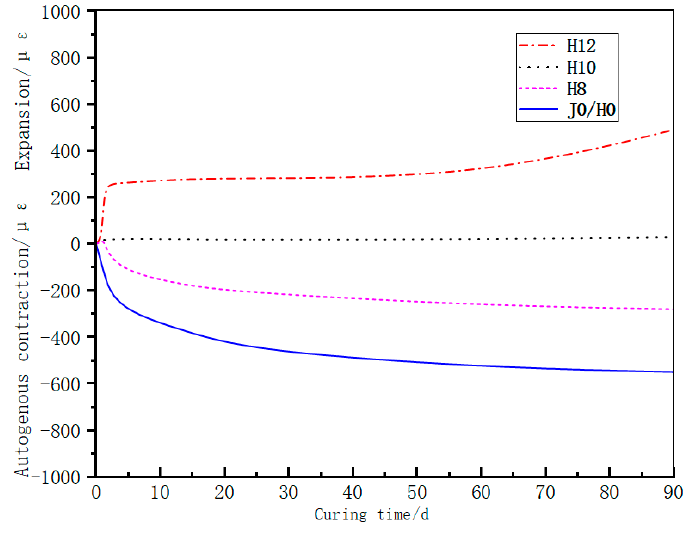
Figure 5. Effect of HPEA on the autogenous shrinkage of concrete.